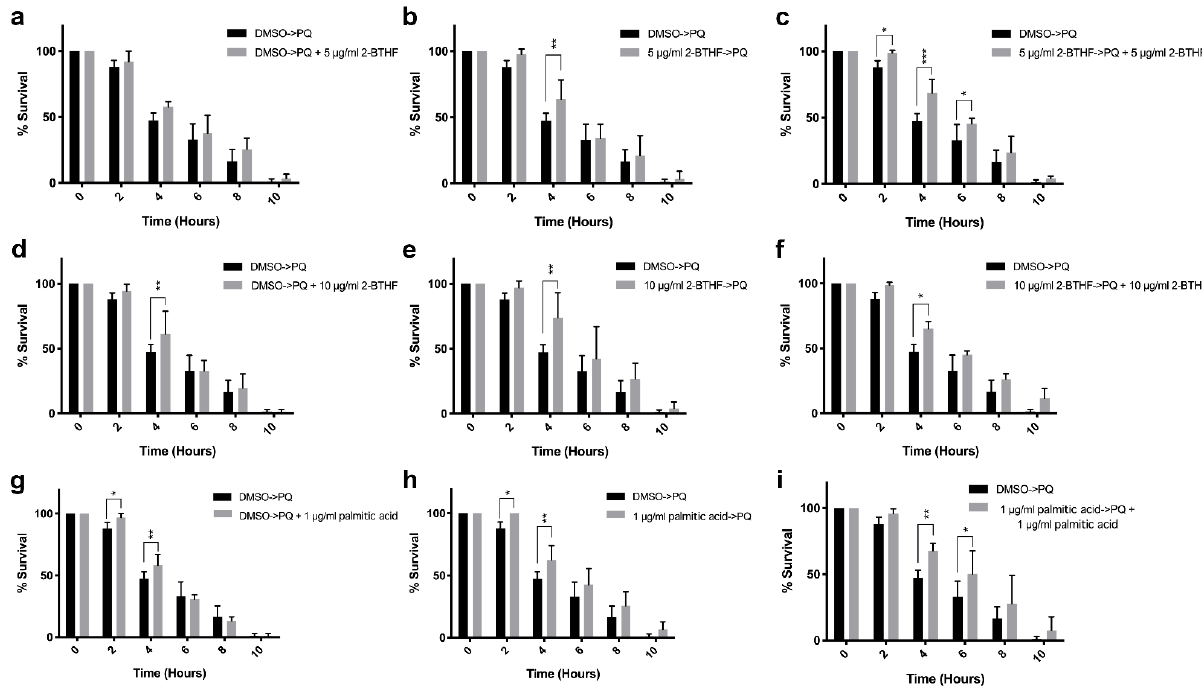
Figure 3. Effects of purified H. scabra compounds on wild type N2 worms’ resistance against oxidative stress: the percentages of survival of worms treated with 5 μ g/mL 2-BTHF and PQ in co-treatment ( a ), pre-treatment ( b ), and all-treatment ( c ) conditions; the percentages of survival of worms treated with 10 μ g/mL 2-BTHF and PQ in co-treatment ( d ), pre-treatment ( e ), and all-treatment ( f ) conditions; the percentages of survival of worms treated with 1 μ g/mL palmitic acid and PQ in co-treatment ( g ), pre-